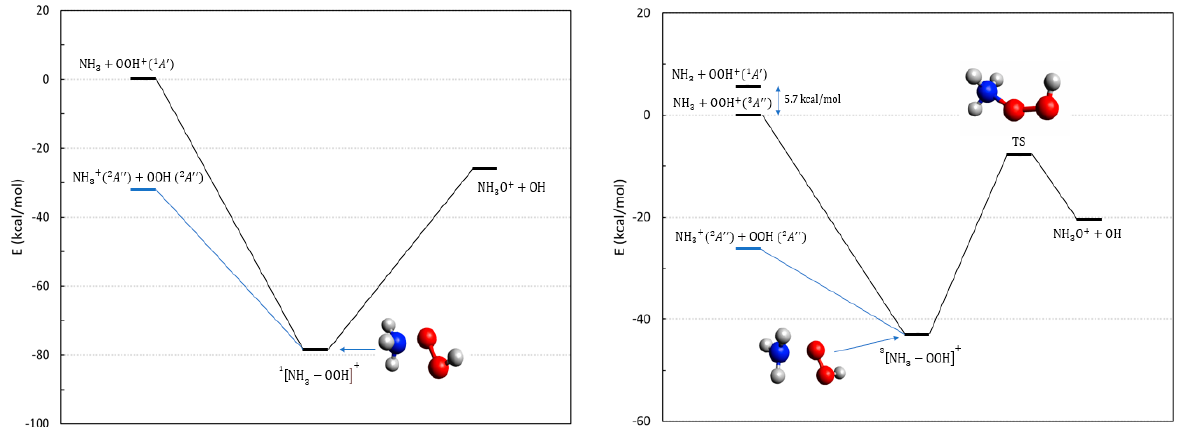
Figure 5. Energetic scheme of the possible entrance and exit channels of reactions 11 – 13 involving the system [ NH 3 − O 2 H ] + with singlet ( left ) and triplet ( right ) multiplicity. The blue line in both panels is the ground state. Energies computed at CCSD(T)/Def2-TZVPP level. The energy of the (cid:0) 1 (cid:1) singlet entrance channel NH 3 + OOH + A (cid:48) is also reported in the right panel for